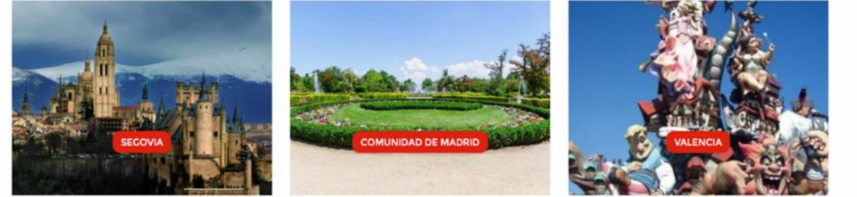
Figure 2. Web site from Tur4all Portugal and Spain with the search engine where the user can select and view the most accessible tourist